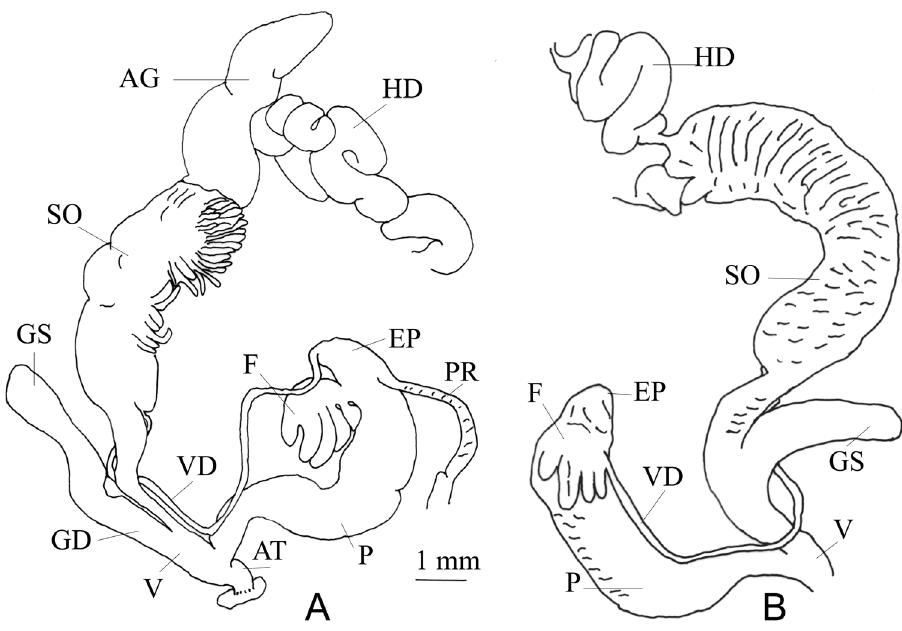
Figure 3. Genitalia of G. orobia : A General view, CDZMTU055P, Maipokhari, Ilam, Eastern Nepal B var. major reproduced from Godwin-Austen (1920), pl. CLXV, fig.